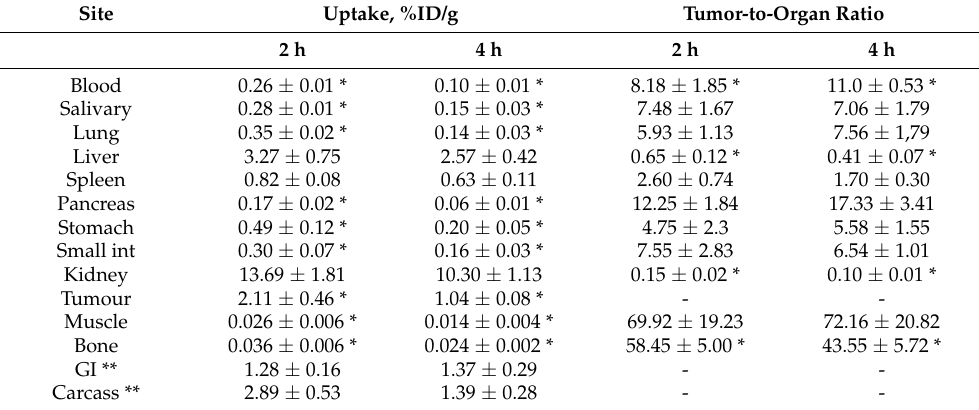
* Significant difference between 2 and 4 h post injection. ** Data for gastrointestinal (GI) tract with content and carcass are presented as % of injected dose per whole